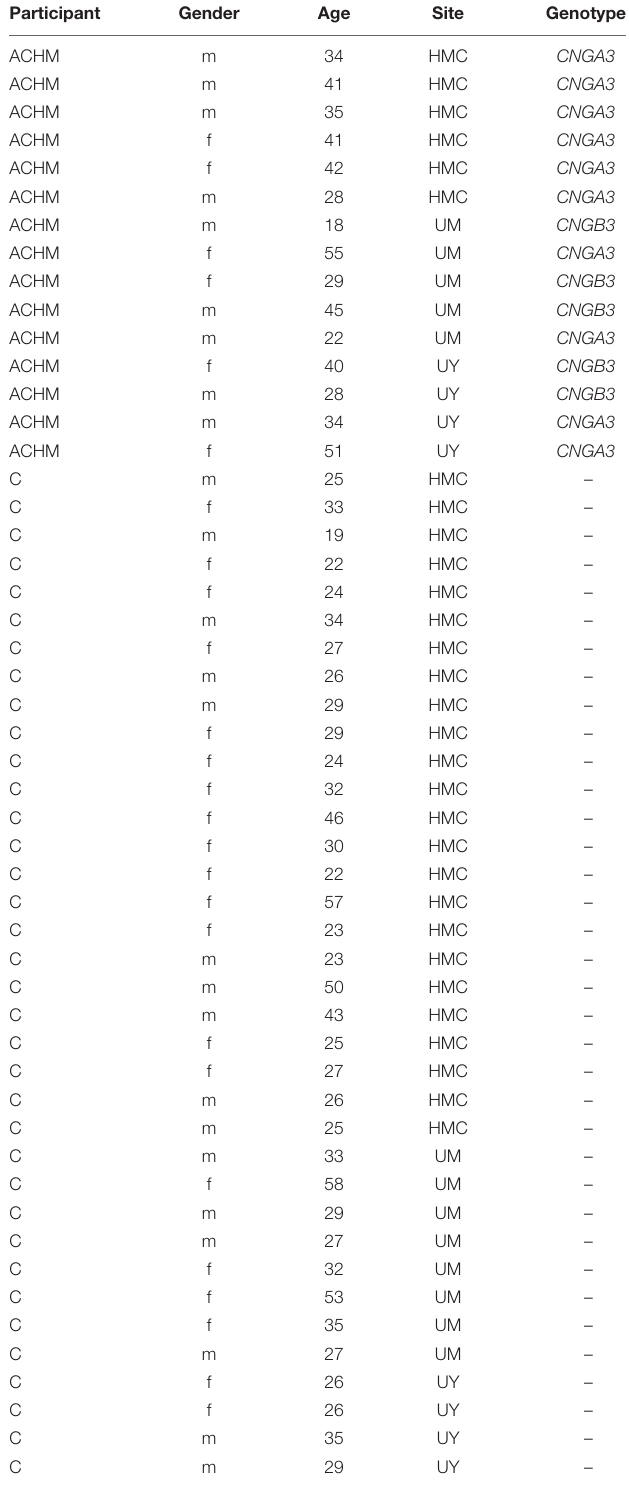
TABLE 1 | Summary of patient demographics showing participant group (ACHM, participants with congenital achromatopsia; C, control participants), gender (m, male; f, female), age, scanner site (HMC, Hadassah Medical Centre; UM, University of Magdeburg; UY, University of York), and